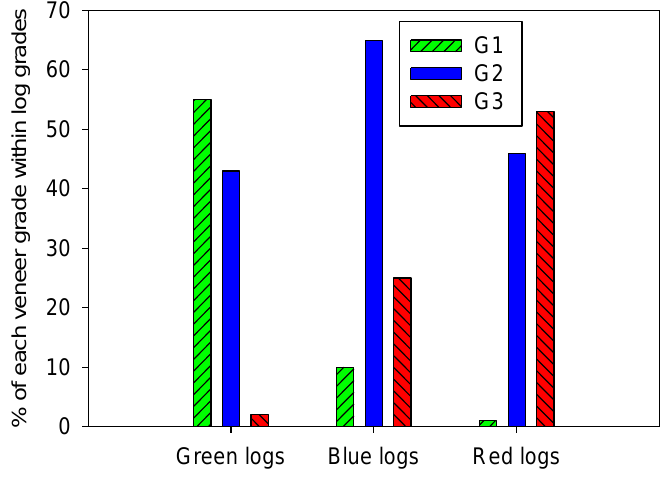
Figure 3. Proportions of veneers of each grade in each log grade. G1, G2 and G3 are veneer grades. Green represents the highest MOE grade and red the